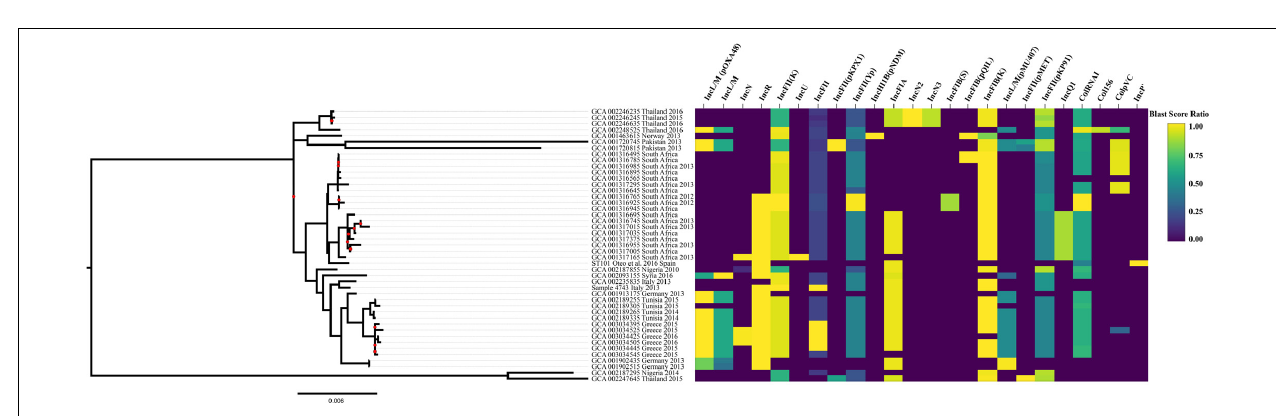
FIGURE 3 | Maximum-likelihood phylogeny of the Klebsiella pneumoniae ST101 lineage. The tree is based on 4,077 SNPs using the K3P+ASC+G4 nucleotide substitution model and includes 45 genomes that collectively cover 85.95% of the reference genome. The PHI test found statistically significant evidence for recombination in this dataset ( P = 0.00e+00). All samples were screened for antibiotic resistance using ResFinder. The percent identity for each resistance gene was plotted using shinyheatmap alongside the phylogenetic tree. Gene lists are in Supplementary Table S6 . MLS includes genes that confer resistance to macrolides-lincosamides-streptogramin B.